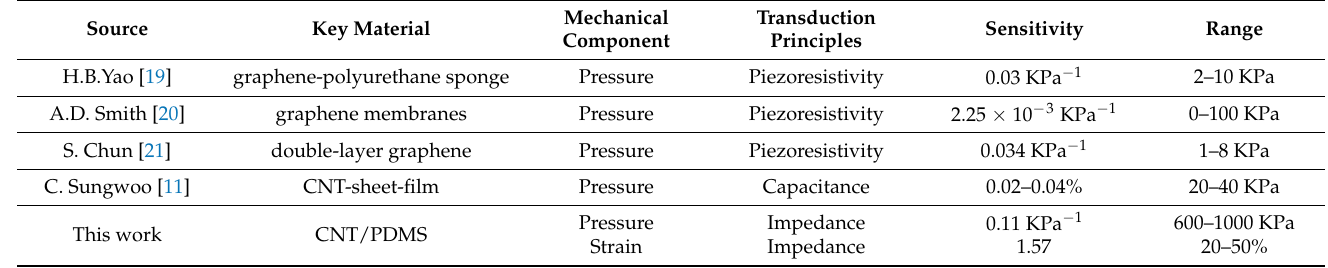
Figure 7. The comparison of relative impedance and resistance change of CNT/PDMS composite under ( a ) pressure and ( b ) tensile strain. Table 1. The comparison between our flexible sensors test results and other sensor test results.